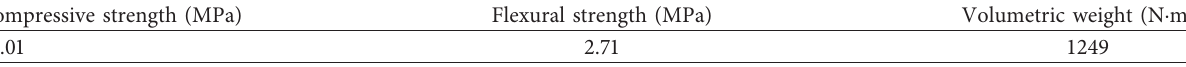
Table 5: Mechanical properties of concrete